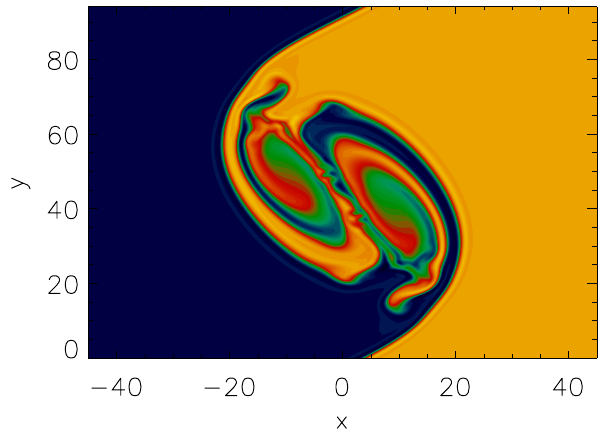
Fig. 9. Shaded isocontours of the passive tracers at t = 300, V 0 = 2. From the left to the right side along the x-axis, the passive tracers, purely advected by the velocity field, represent the magnetospheric (blue) and magnetosheath (yellow) plasma separated by the transi- tion region (green and orange).